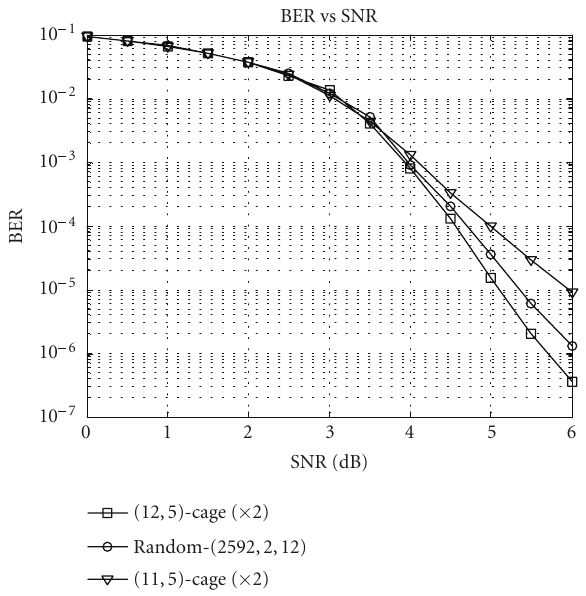
Figure 3: BER performances of ( k ,5) cage codes (25 iterations).